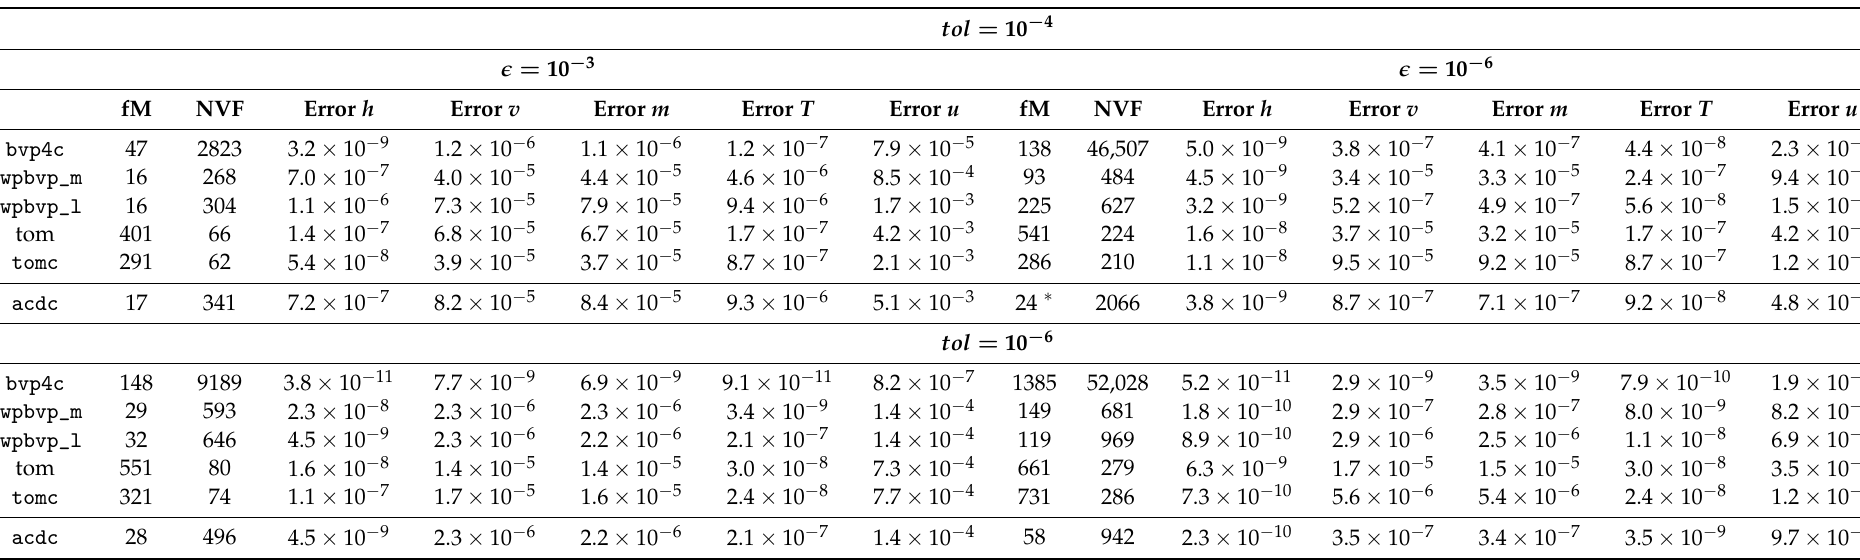
Table 19. Goddard Rocket Problem (15) solved using a piecewise quadratic penalty function with ¯ σ = 10 − 4 and the continuation strategy: final mesh (fM), total number of vectorized function evaluation (NVF) and mixed errors for h , v , m , T and u . ∗ Observe that acdc for tol = 10 − 4 , (cid:101) = 10 − 6 obtains a solution for (cid:101) = 3.98 × 10 − 6